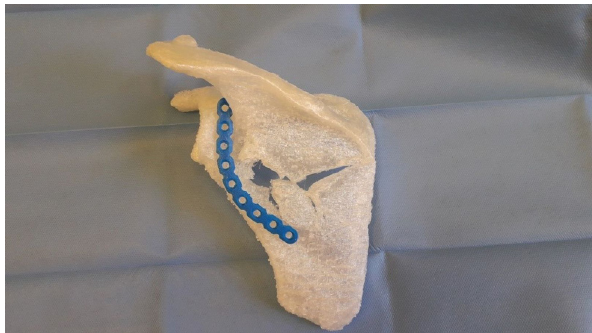
Figure 6: 3D print of the scapula model and the implant.